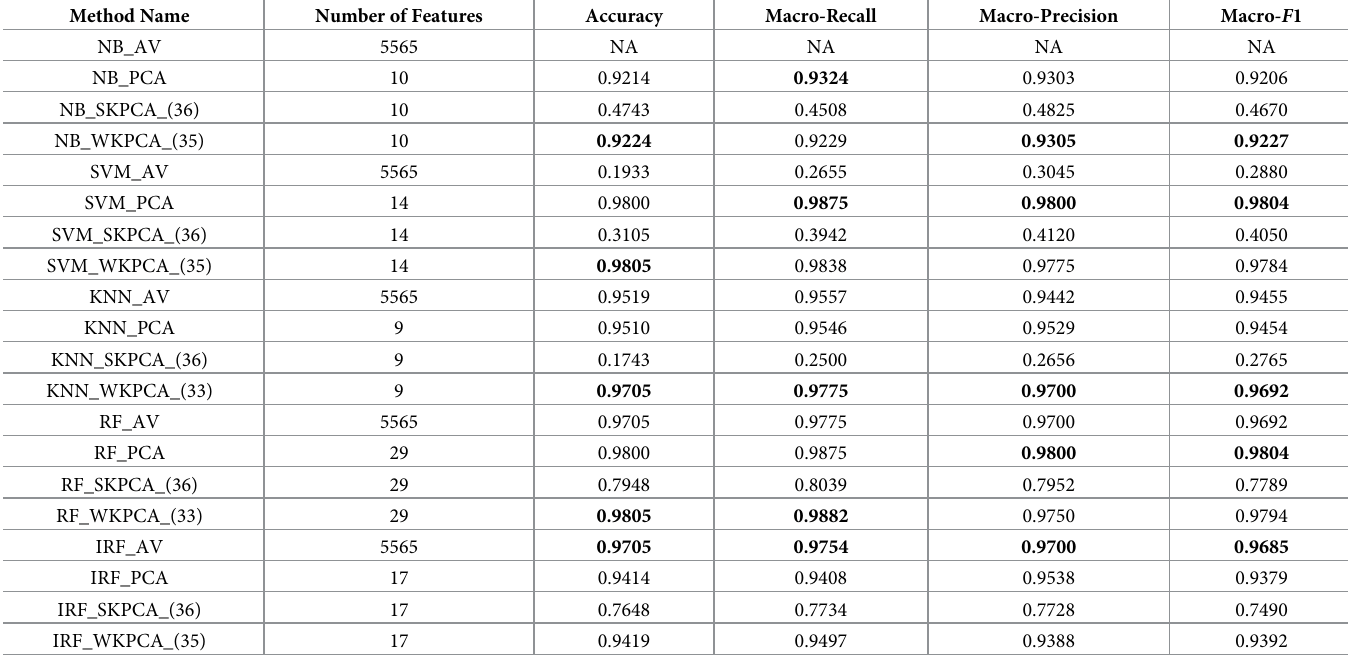
Table 7. Performance measurement comparisons of machine learning methods based on the Multi-A data set after WKPCA dimension reduction.